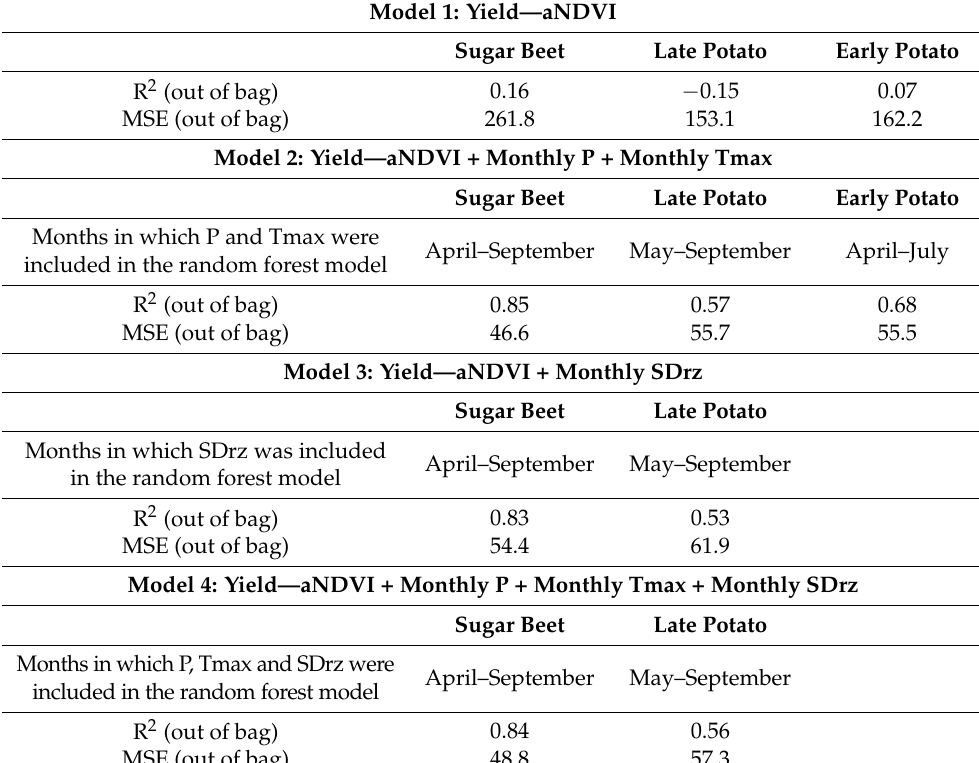
Table 2. Model performance indicators for the random forest models based on monthly environmental variables. P: precipitation, Tmax: maximum temperature, SDrz: root-zone soil water depletion. Model 1: Yield—aNDVI Sugar Beet Late Potato Early